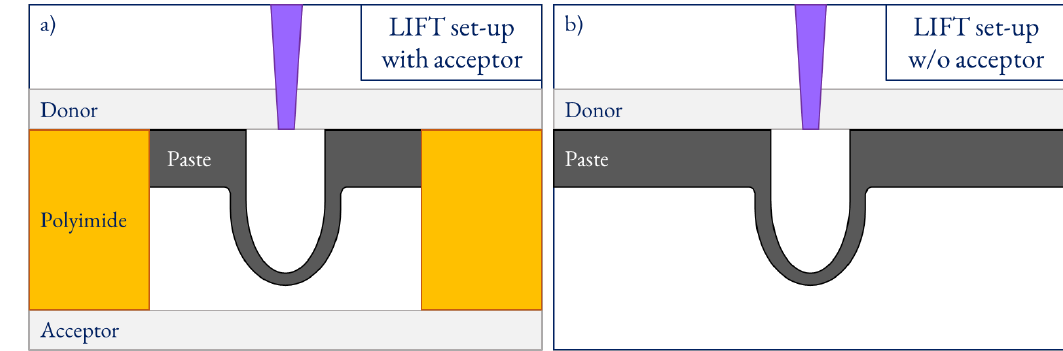
Figure 1. LIFT setup for the transference of high-viscosity pastes with an acceptor at a gap set by a polyimide tape ( a ) and without acceptor ( b ).